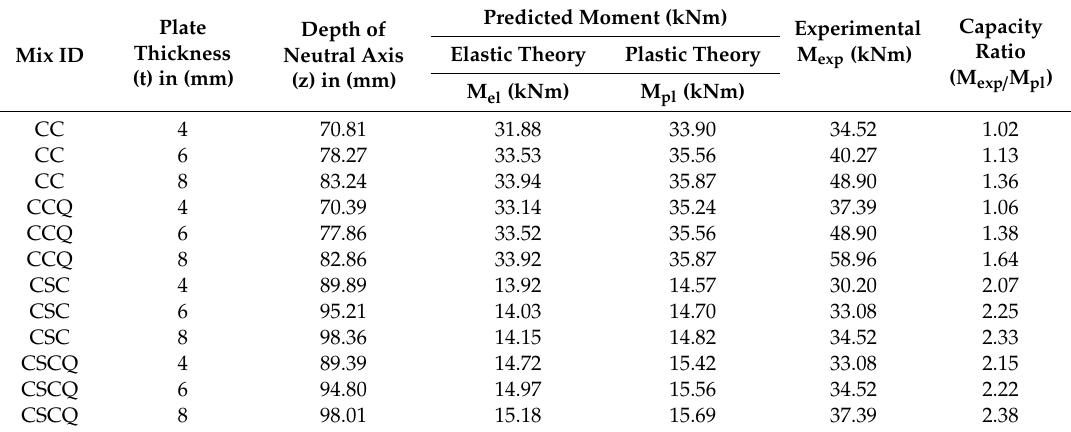
Table 4. Comparison of experimental moments with predicted